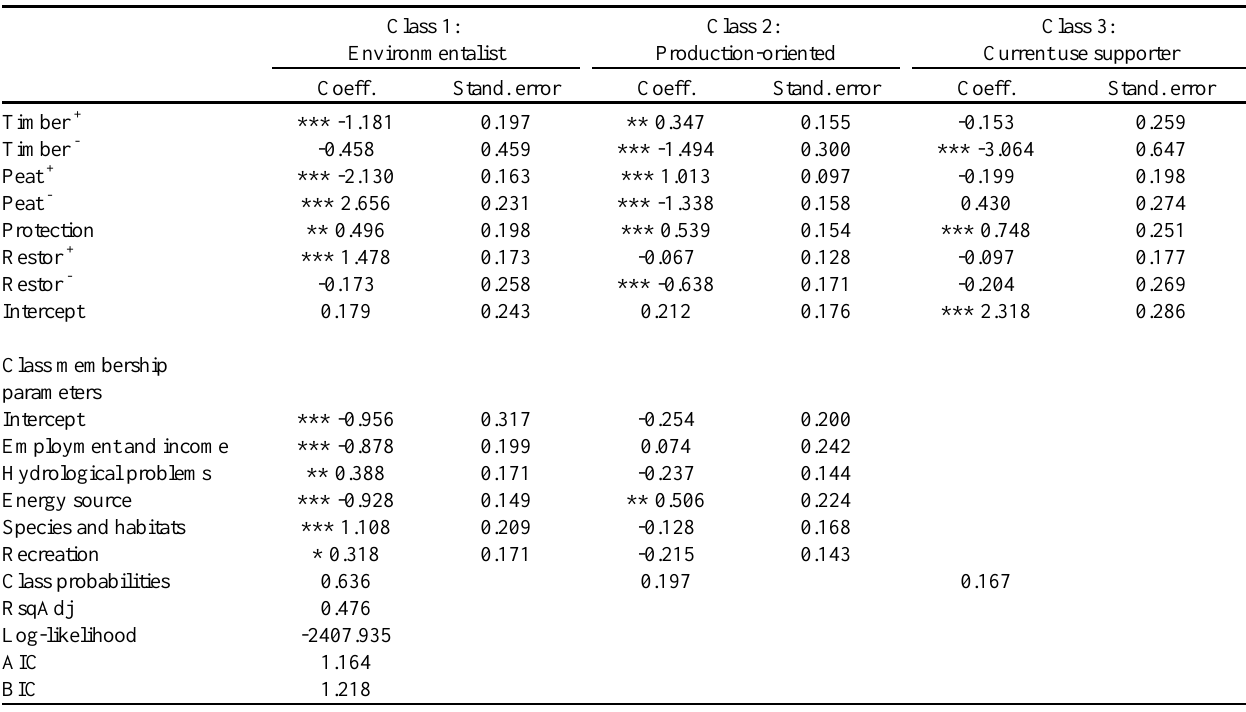
Table 4 . Results of the 3-class latent class model (LCM) including opinions on the ecosystem services of peatlands as explanatory variables for class membership. The class membership coefficients for Class 3 were fixed in order to identify the remaining coefficients. Number of respondents = 712.